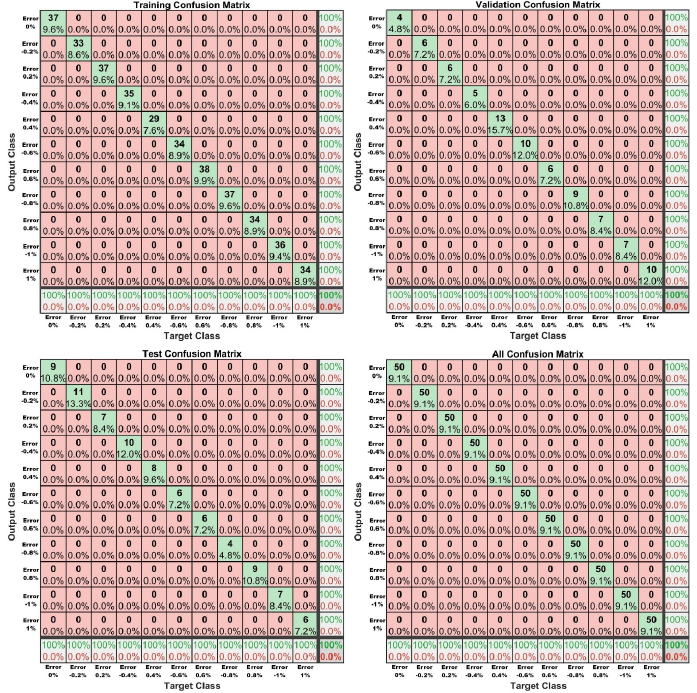
Figure 20. Neural network confusion matrix.